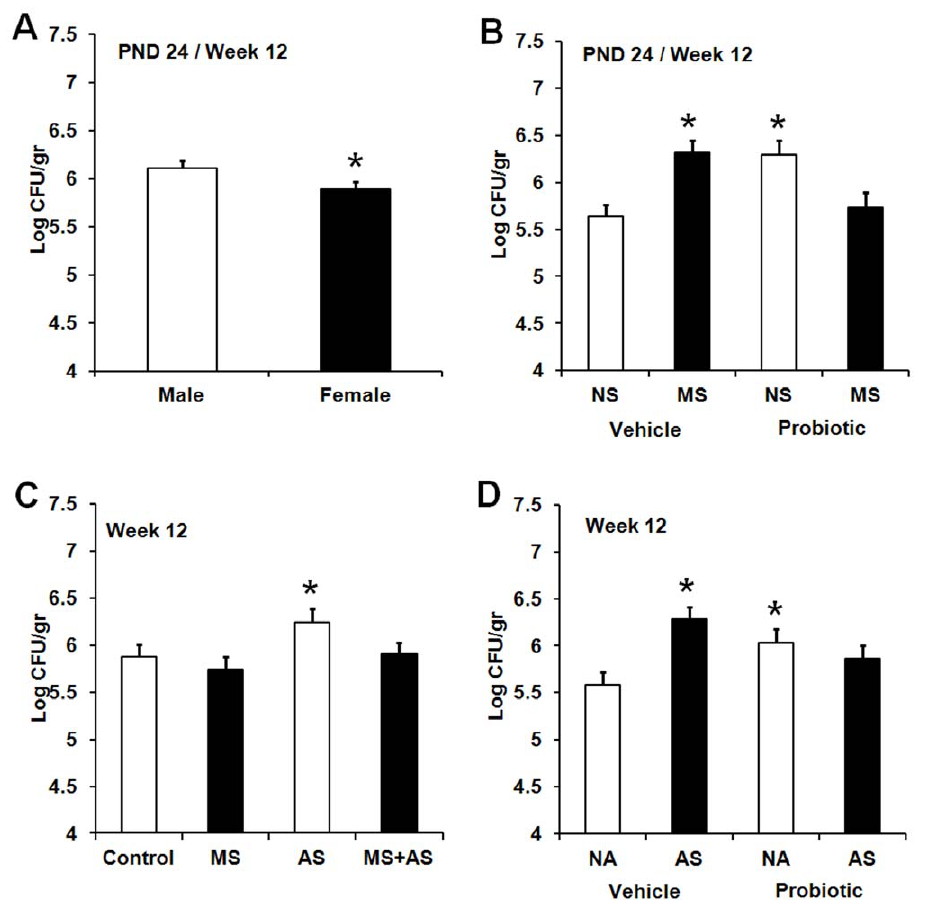
Figure 10. Effect of maternal probiotic intake, stress and gender on faecal counts of E.coli . A ) Effect of sex on faecal counts of E. coli (Log CFU/gr, least squares means + SE) in rats. The figure presents aggregated data across test days (PND 24 and 86).The hollow bar represents males (M, n=109) and the filled bar represents females (F, n=112). An asterisk (*) indicates statistical significant difference ( p # 0.05). B ) Effect of maternal probiotic intake and neonatal maternal separation (MS) on faecal counts of E. coli (Log CFU/gr, least squares means + SE). The figure presents aggregated data across test days (PND 24 and 86).The hollow bars represent animals exposed to no-MS (NS): NS vehicle (n=52), NS probiotic (n=51). The filled bars represent animals exposed to MS: MS vehicle (n=60), MS probiotic (n=56). An asterisk (*) indicates statistical significant difference relative to vehicle NNS animals (p # 0.05). C ) Effect of MS and AS on faecal counts of E. coli (Log CFU/gr, least squares means + SE) in adult Wistar rats (week 12). The hollow bars represent no-stress control animals or those exposed to AS: control (n=33), AS (n=37). The filled bars represent animals exposed to MS or MS + AS: MS (n=38), MS + AS (n=39). An asterisk (*) indicates statistical significant difference compared to the control ( p # 0.05). D ) Effect of maternal probiotic intake and AS on faecal counts of E. coli (Log CFU/gr, least squares means + SE) in adult Wistar rats (week 12). The hollow bars represent animals exposed to no-AS (NA): NA vehicle (n=38), NA probiotic (n=33). The filled bars represent animals exposed to AS: AS vehicle (n=40), AS probiotic (n=36). An asterisk (*) indicates statistical significant difference relative to vehicle NAS animals ( p #